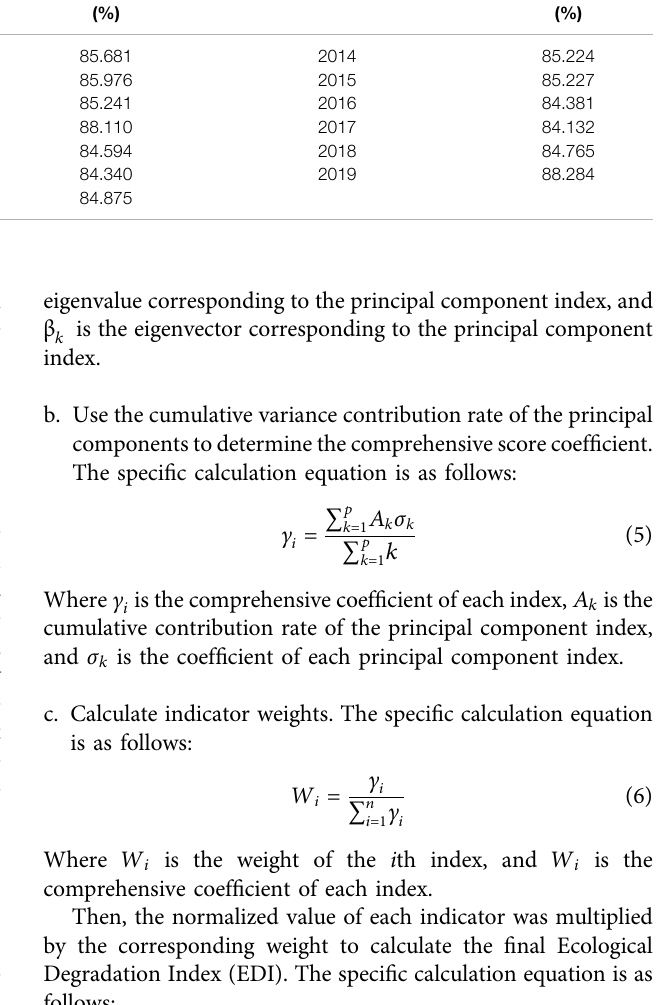
TABLE 2 | Cumulative variance contribution rate (%) of principal components obtained by principal component analysis from 2000 to 2019. Years Cumulative variance contribution rate